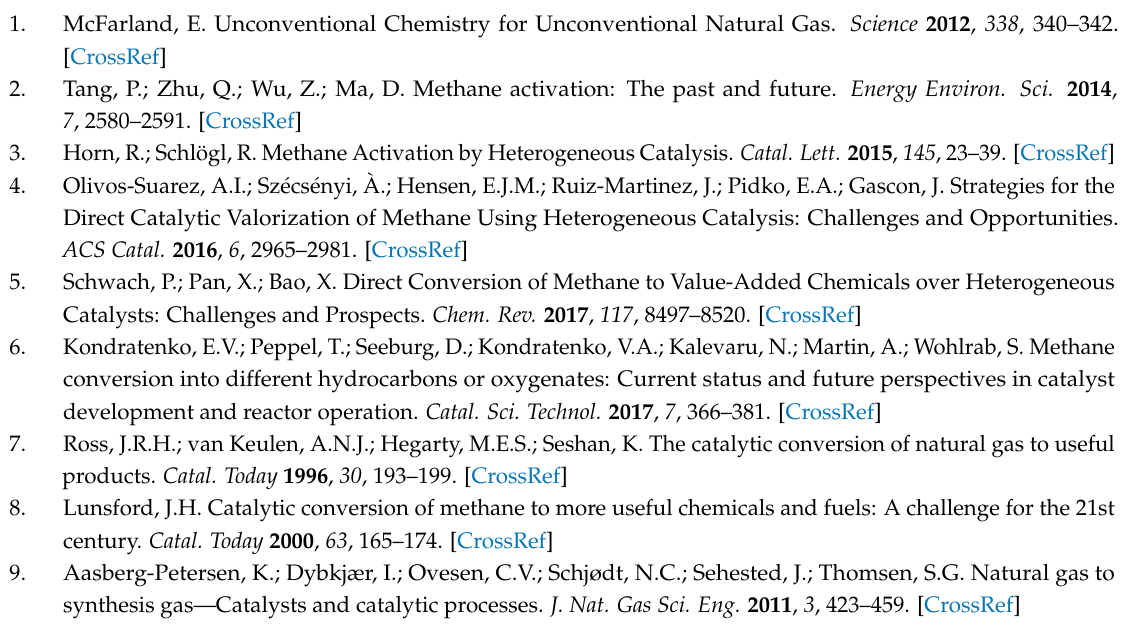
Figure S7. H 2 volumetric gas contents (water and inert gas excluded) in the steam reforming of methane over Rh1/Al 2 O 3 at various temperatures and S/C ratios of (a) 1,(b) 2.5 and (c) 4; Figure S8. H 2 /CO ratios in the product gases in the steam reforming of methane over Rh1/Al 2 O 3 at various temperatures and S/C ratios of (a) 1, (b) 2.5 and (c) 4; Figure S9. Volumetric CO- and CO 2 -contents in the product gases (water and inert gas excluded) in the steam reforming of methane over Rh1/Al 2 O 3 at various temperatures and S/C ratios of (a) 1, (b) 2.5 and (c)